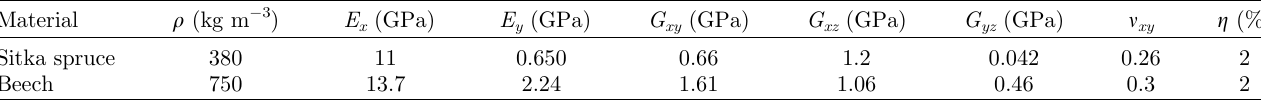
Table 2. Mechanical properties of the materials used for the study. q is the mass density, E x and E y are the Young modulus in the x and y direction, respectively. G denotes the shear modulus, m is the Poisson coef fi cient, and g is the modal loss factor.